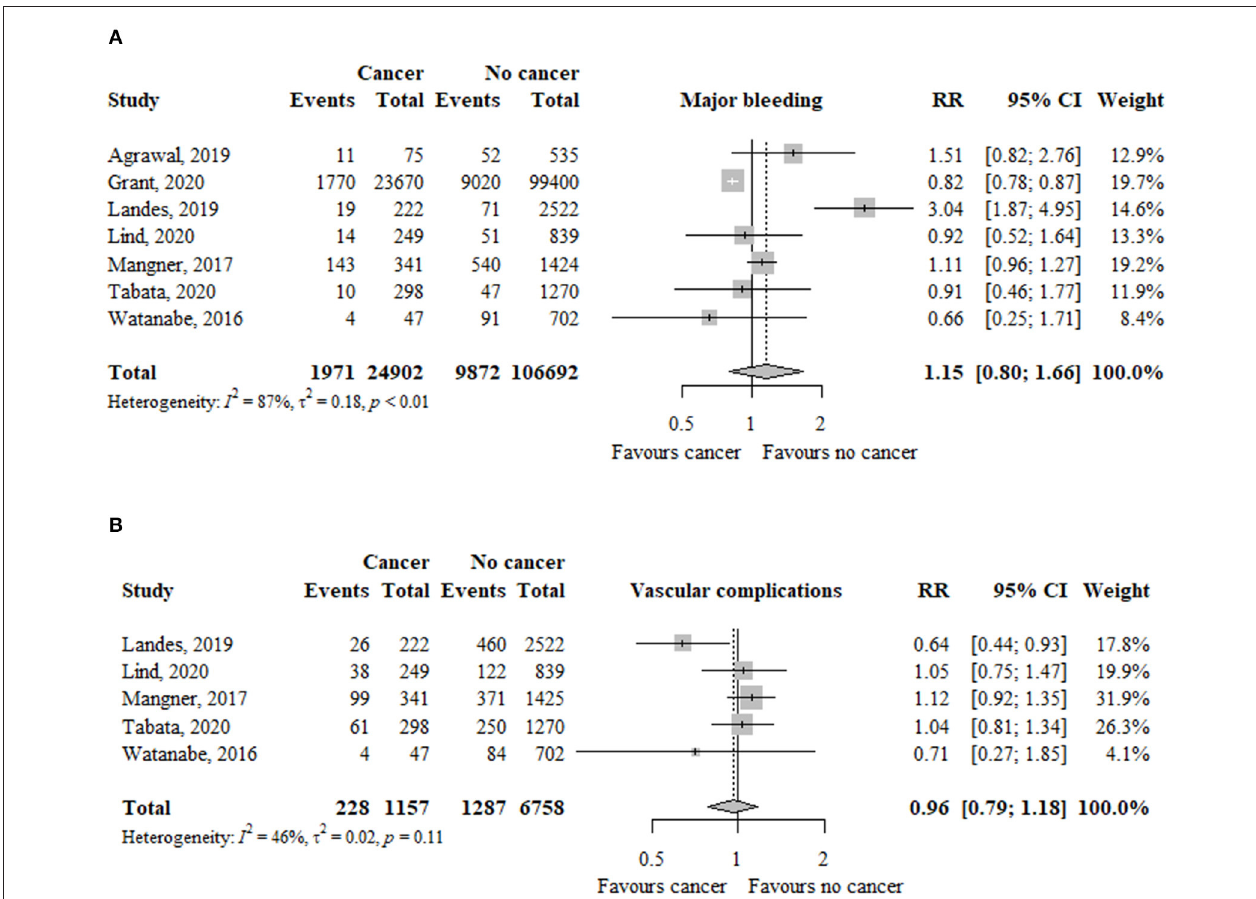
FIGURE 4 | Association between cancer and (A) acute kidney injury and (B) pacemaker implantation in TAVR patients. RR, relative risk; aHR, adjusted hazard ratio; CI, confidence interval; TAVR, transcatheter aortic valve